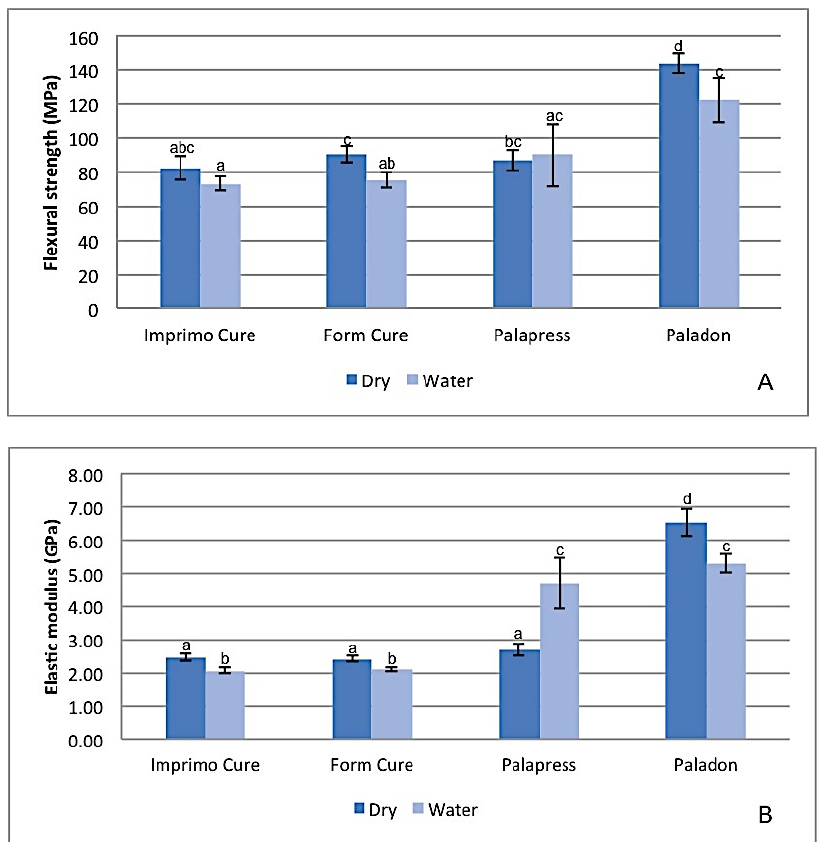
Figure 1. Diagram of flexural strength and elastic modulus mean values for tested groups. Same superscripted lowercase letters illustrate groups/subgroups not statistically significantly different when compared by Dunnett’s T3 post hoc analysis ( p >